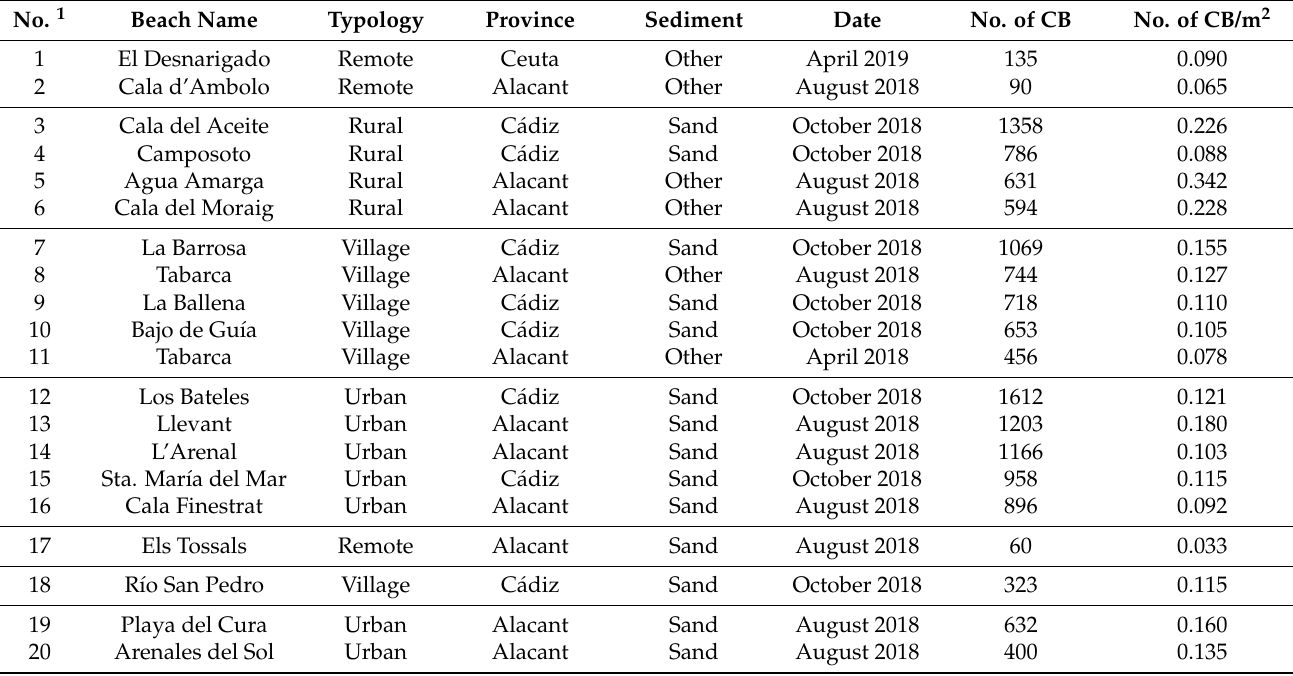
Table 2. Beaches that contained an unusual number of cigarette butts (CB) according to beach typology.